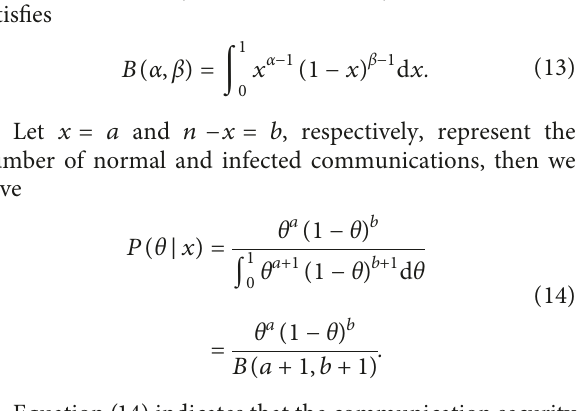
Figure 4: System framework of CC 2